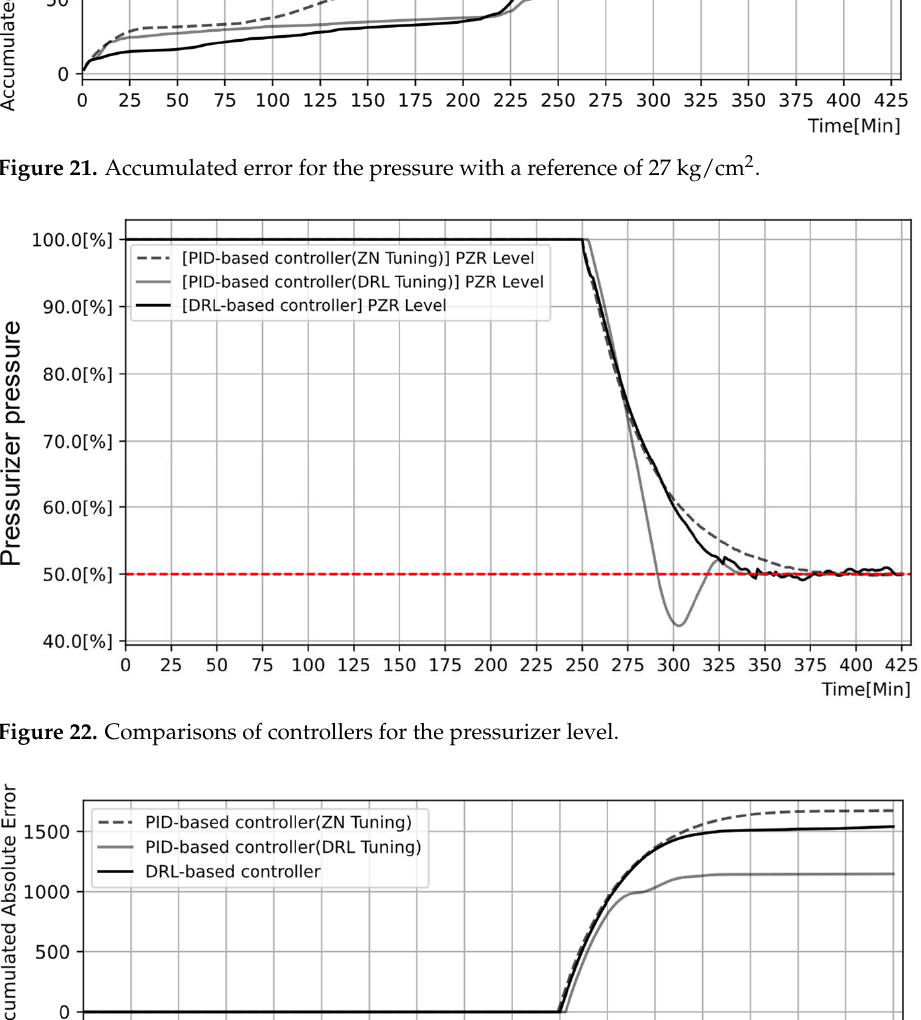
Figure 23. Accumulated error for the level with a set-point of 50%.